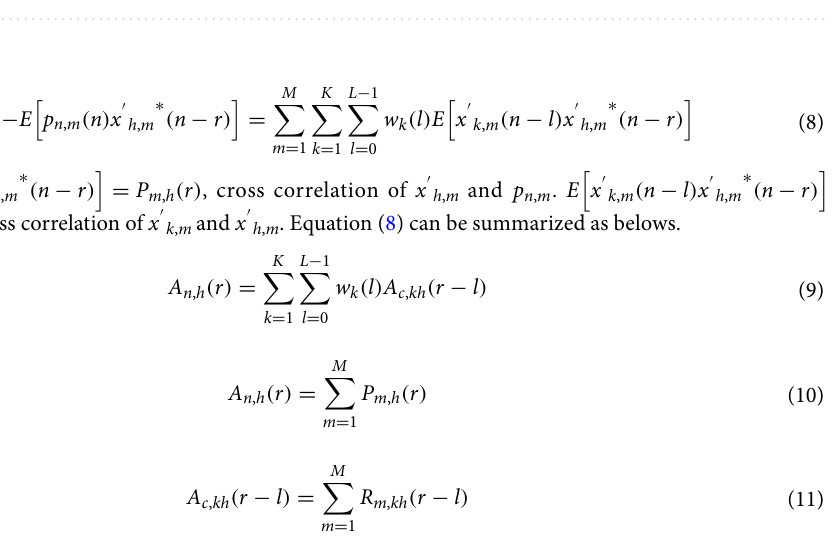
Figure 2. Flow chart of open-loop acoustic power minimization algorithm. Since a large number of microphones are required for acoustic power measurements, an open-loop ANC algorithm, which does not require a microphone during ANC, is used. The control filter is calculated by a preliminary experiment that minimizes acoustic power in anechoic chamber. Microphones are placed on a spherical surface surrounding the noise source. Here, x is the reference signal, w k is the control filter of kth control speaker, and S k , m is the secondary path from the kth control speaker to the mth microphone. p n , m is the sound pressure by the noise source at the mth microphone and p c , m is the sound pressure by control speakers at the mth error